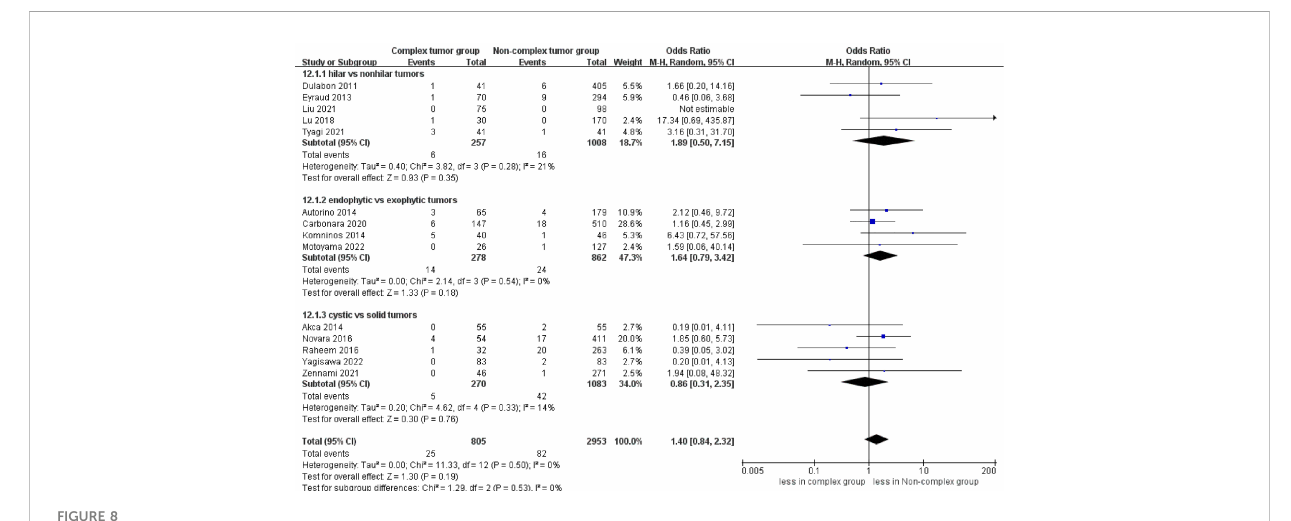
FIGURE 8 Forest plots of oncologic